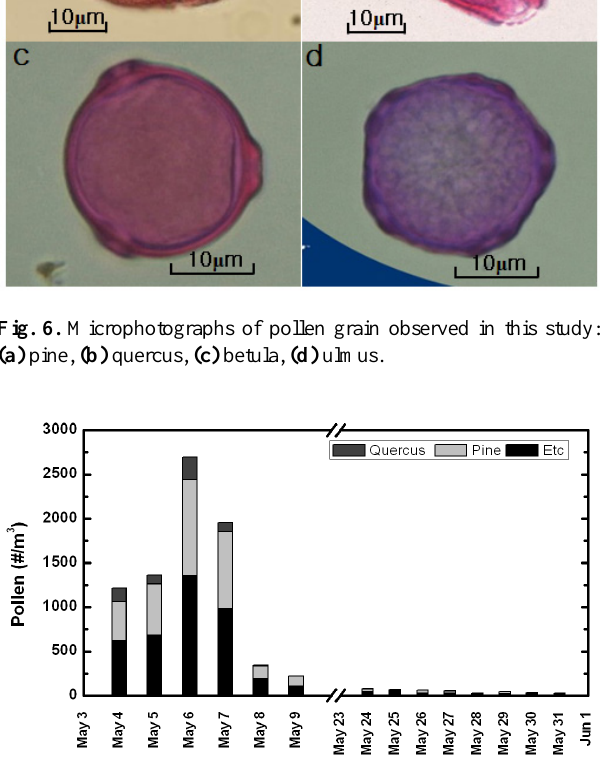
Fig. 7. Daily distribution of pollen counts from 4 to 9 May and from 24 to 31 May at Gwangju, Korea.